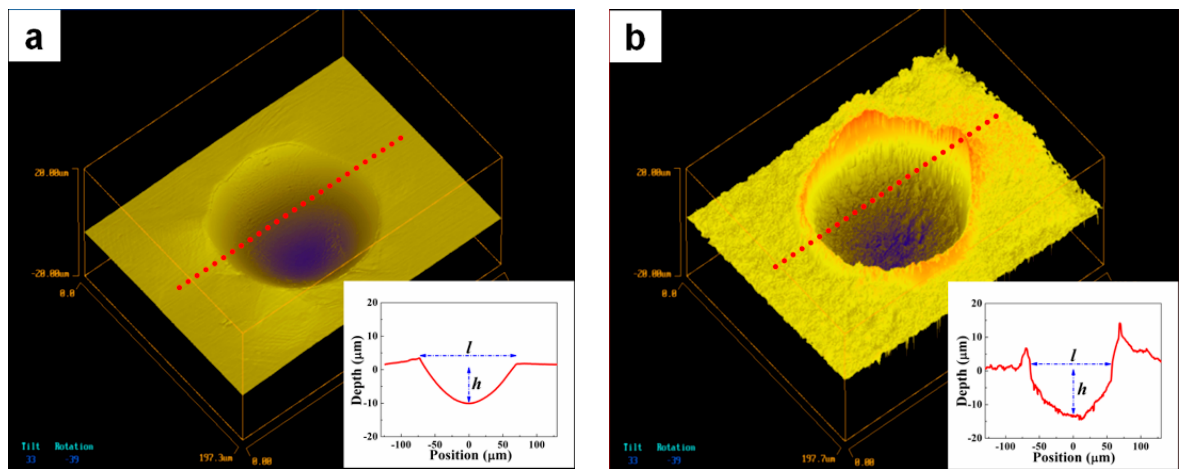
Figure 2. The profiles of a typical indent created by a spherical indenter with 200 µm radius using 30 N loading prior to ( a ) and after ( b ) oxidation at 1200 °C for 25 h. The inset is the line scan of the location indicated by the red dotted line. Table 1. The depth, span and calculated radius of a typical indent shown in Figure 1.